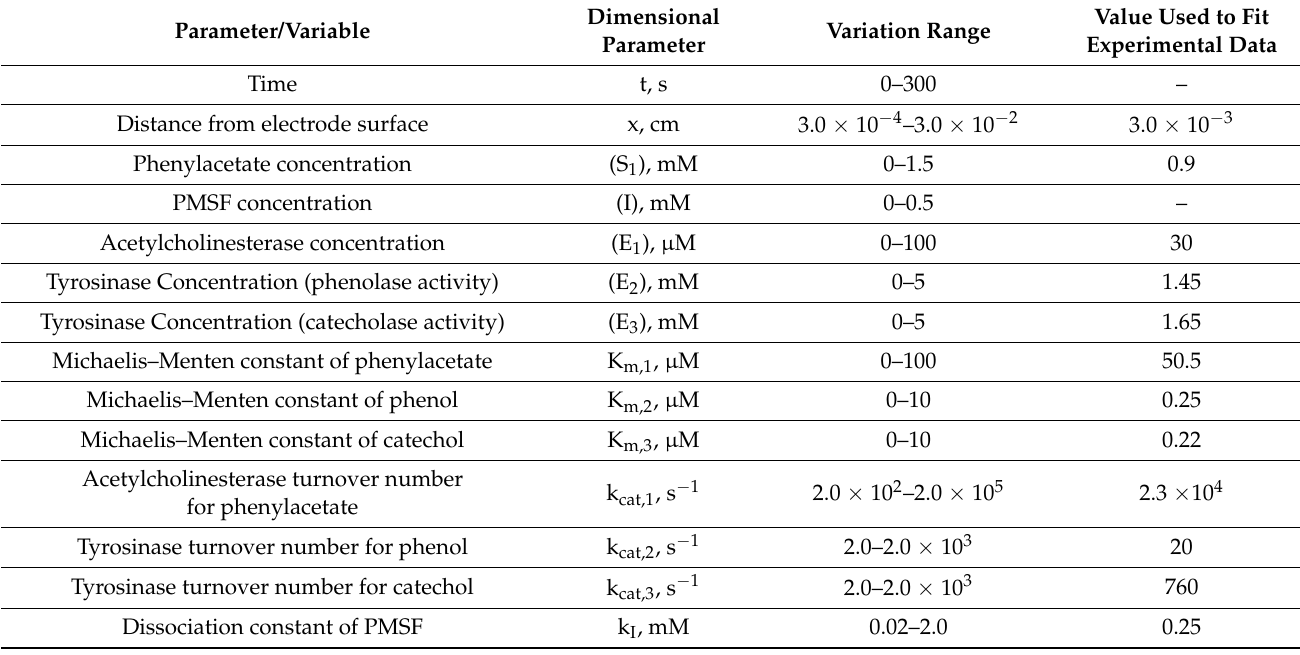
Table 1. Parameters and variables used in the numerical